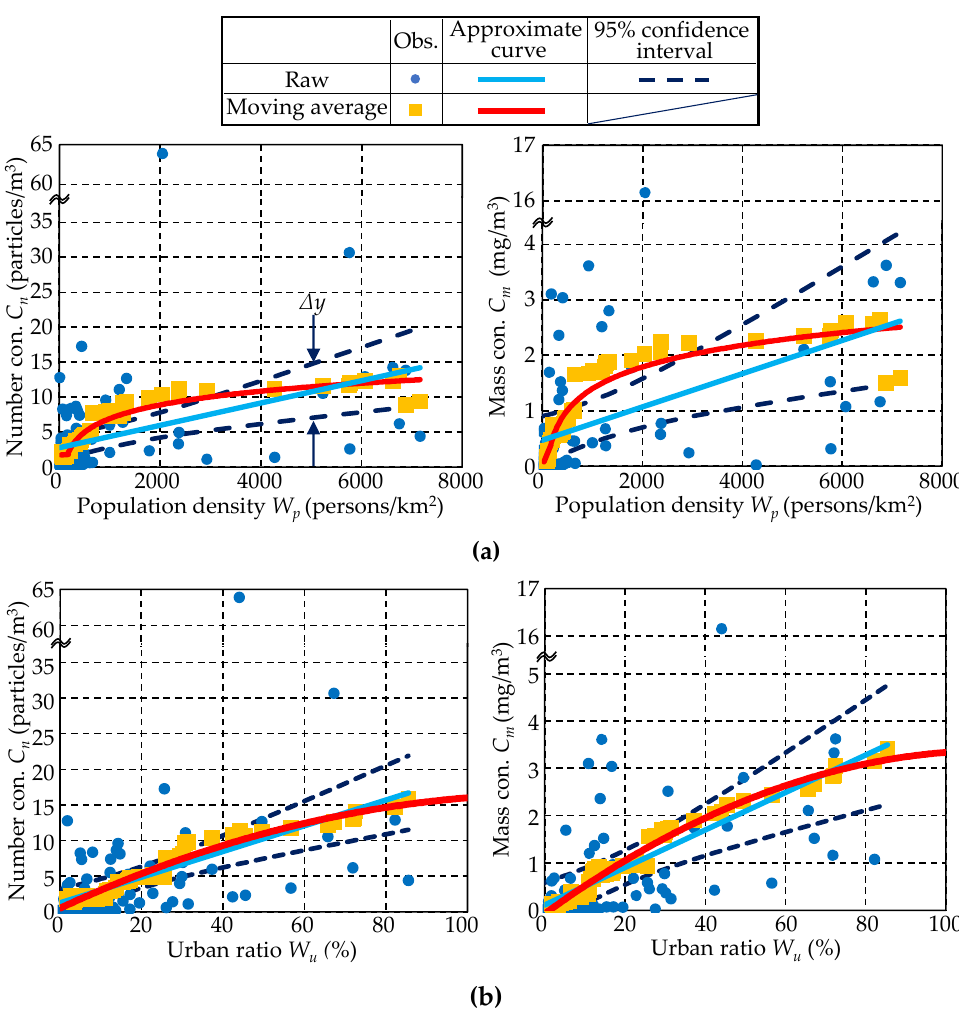
Figure 5. Correlation between MicP concentrations and population density, W p , ( a ) and urban ratio, W u , ( b ) for raw and moving average data. The stippled line represents the 95% confidence interval around the linear approximation.